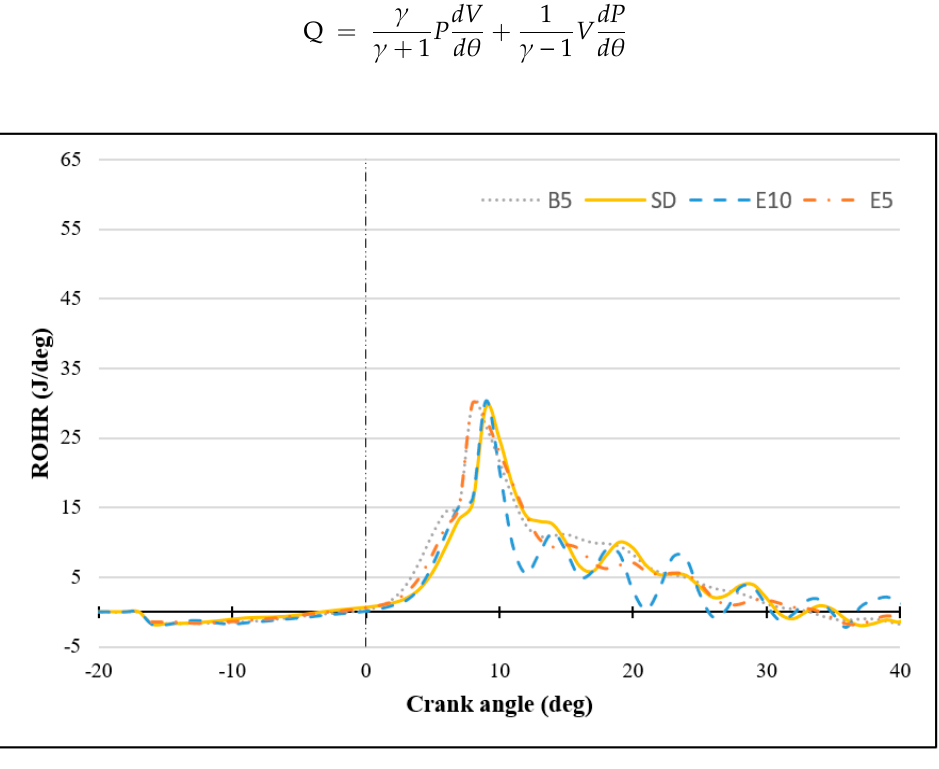
Figure 13. Comparison of the ROHR at 1 kW for various fuels.